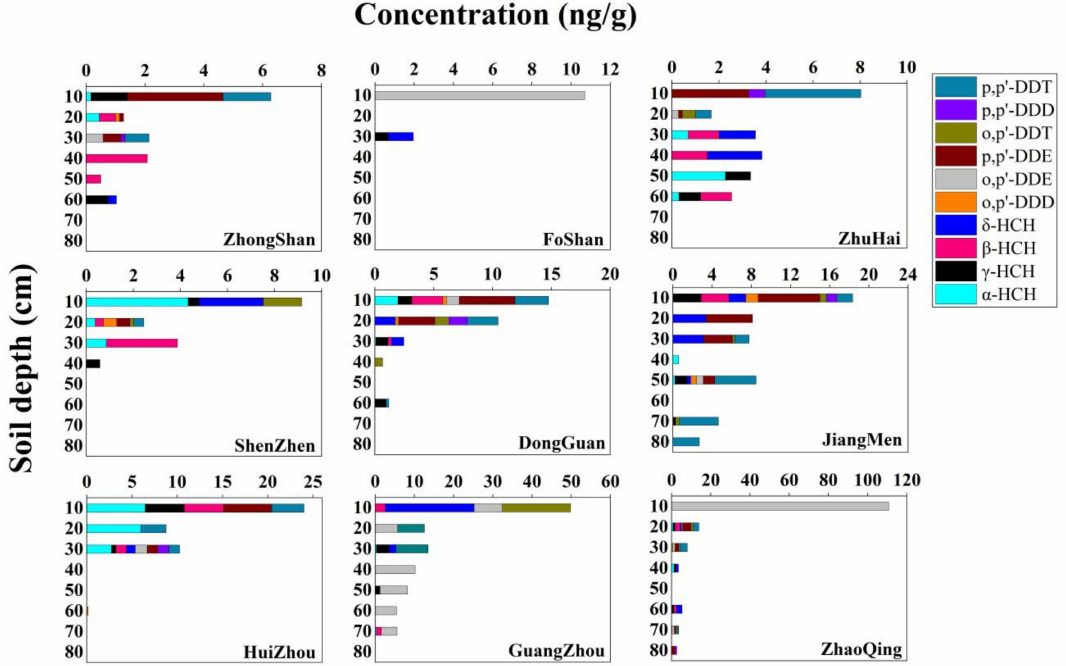
Figure 2. Vertical distributions of the concentrations and compositions of OCPs in agricultural soils of the